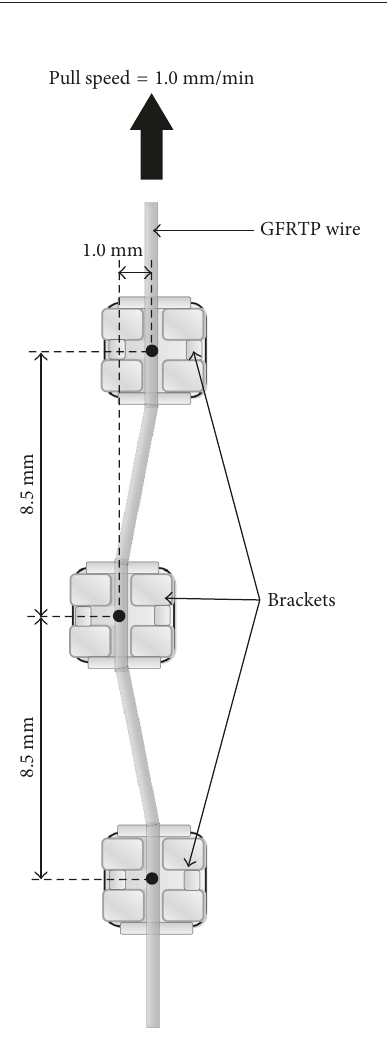
Figure 1: Illustration of the frictional testing